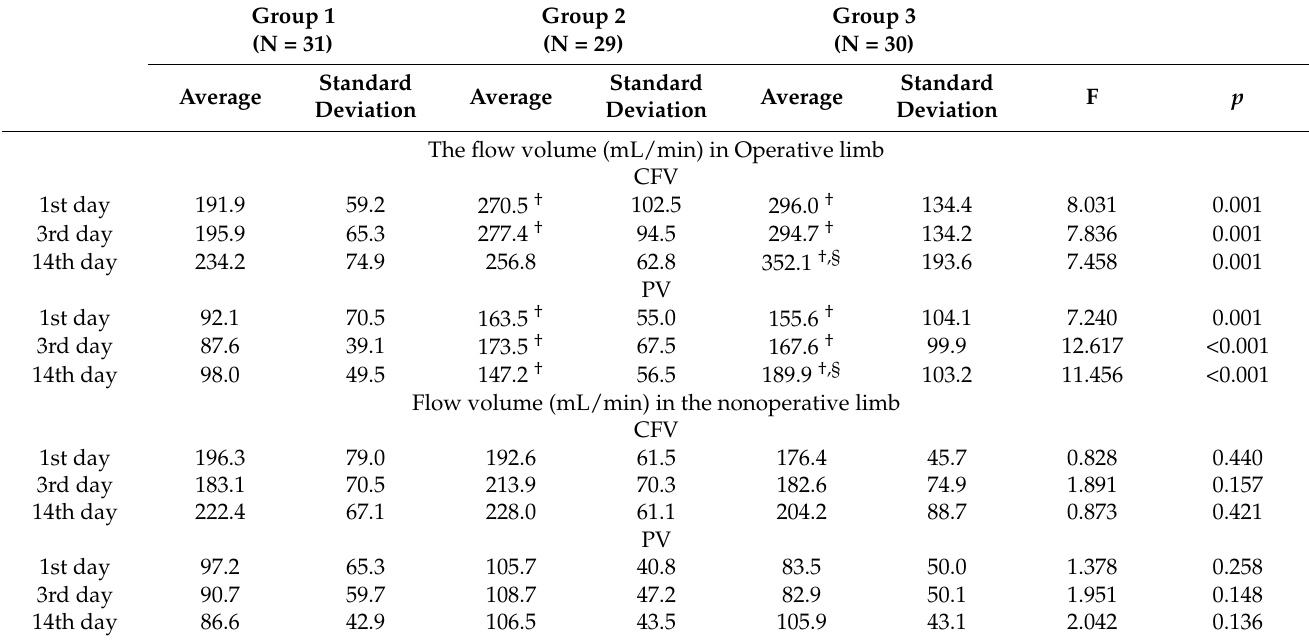
Table 3. Flow volume in the common femoral vein (CFV) and popliteal vein (PV) after the surgery.